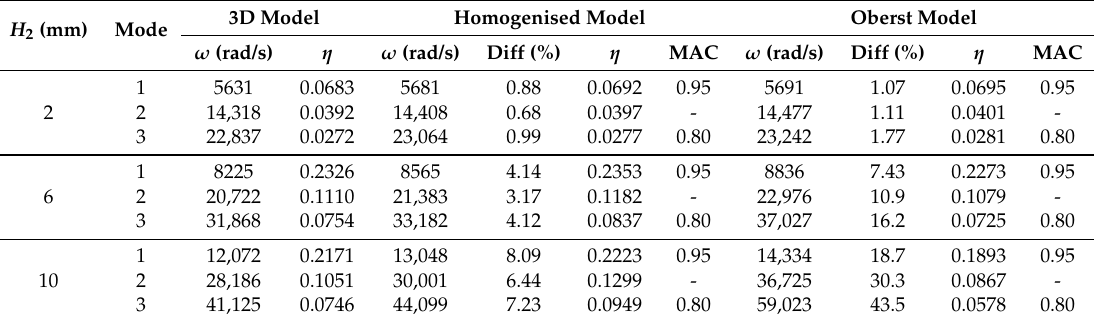
Table 2. Natural frequencies and loss factors of the simply supported FLD plate computed with the three models. For the plate models, the percent difference in frequency and MAC value in comparison to the 3D models is shown. MAC value is omitted for double